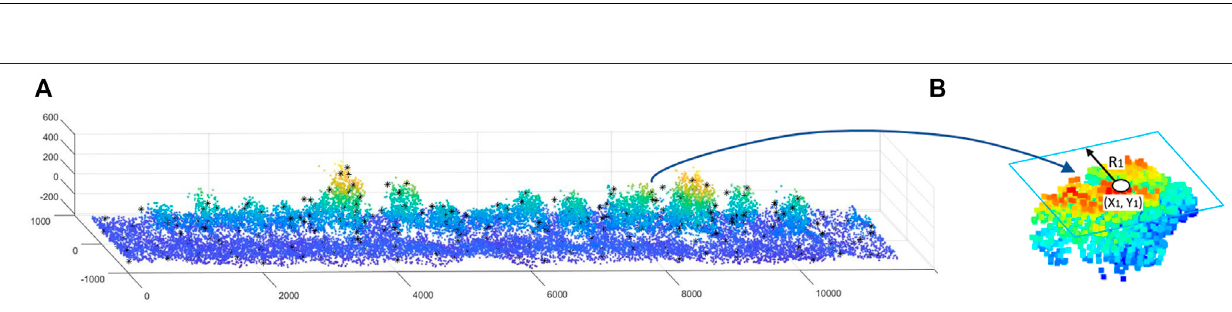
(cid:129) Application of multispectral images to develop fertilization strategies and monitoring the state of vegetables in Cardim Ferreira Lima et al. (2020). (cid:129) Reconstruction and analysis of multispectral images in crop rows in Krus et al. (2021). (cid:129)